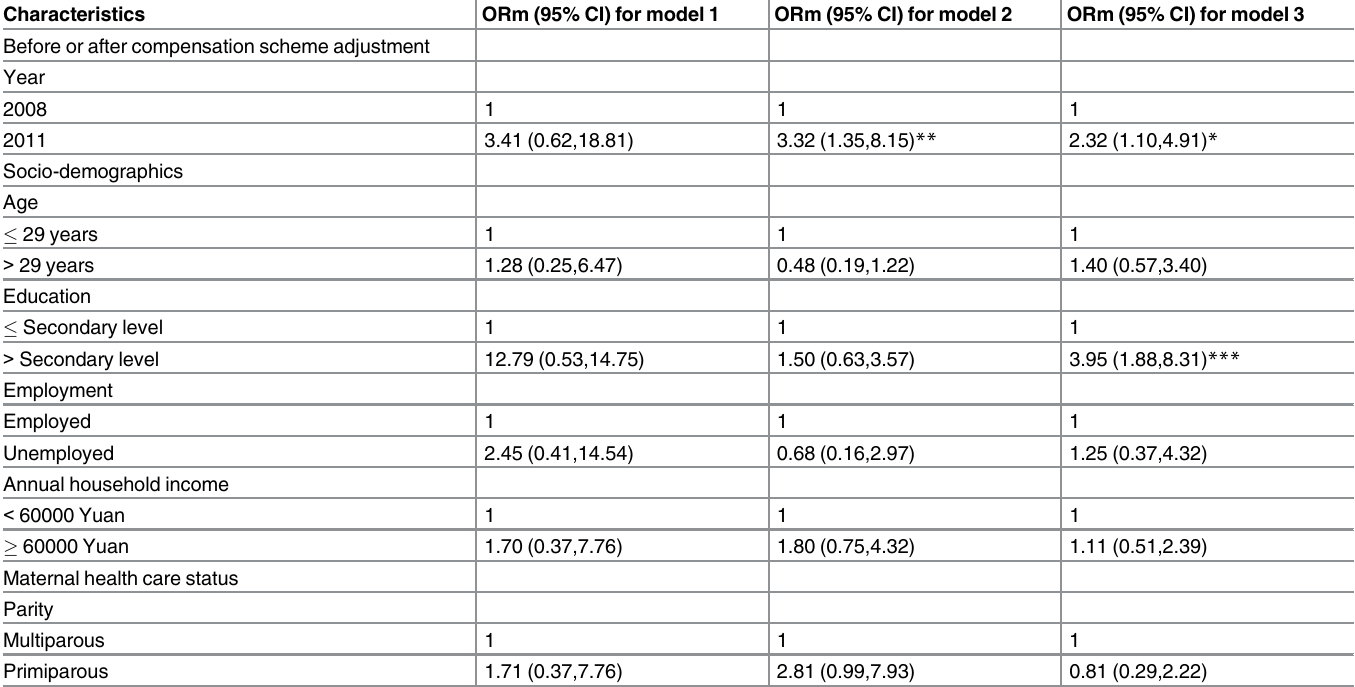
Table 2. OR and 95% CI for maternal services